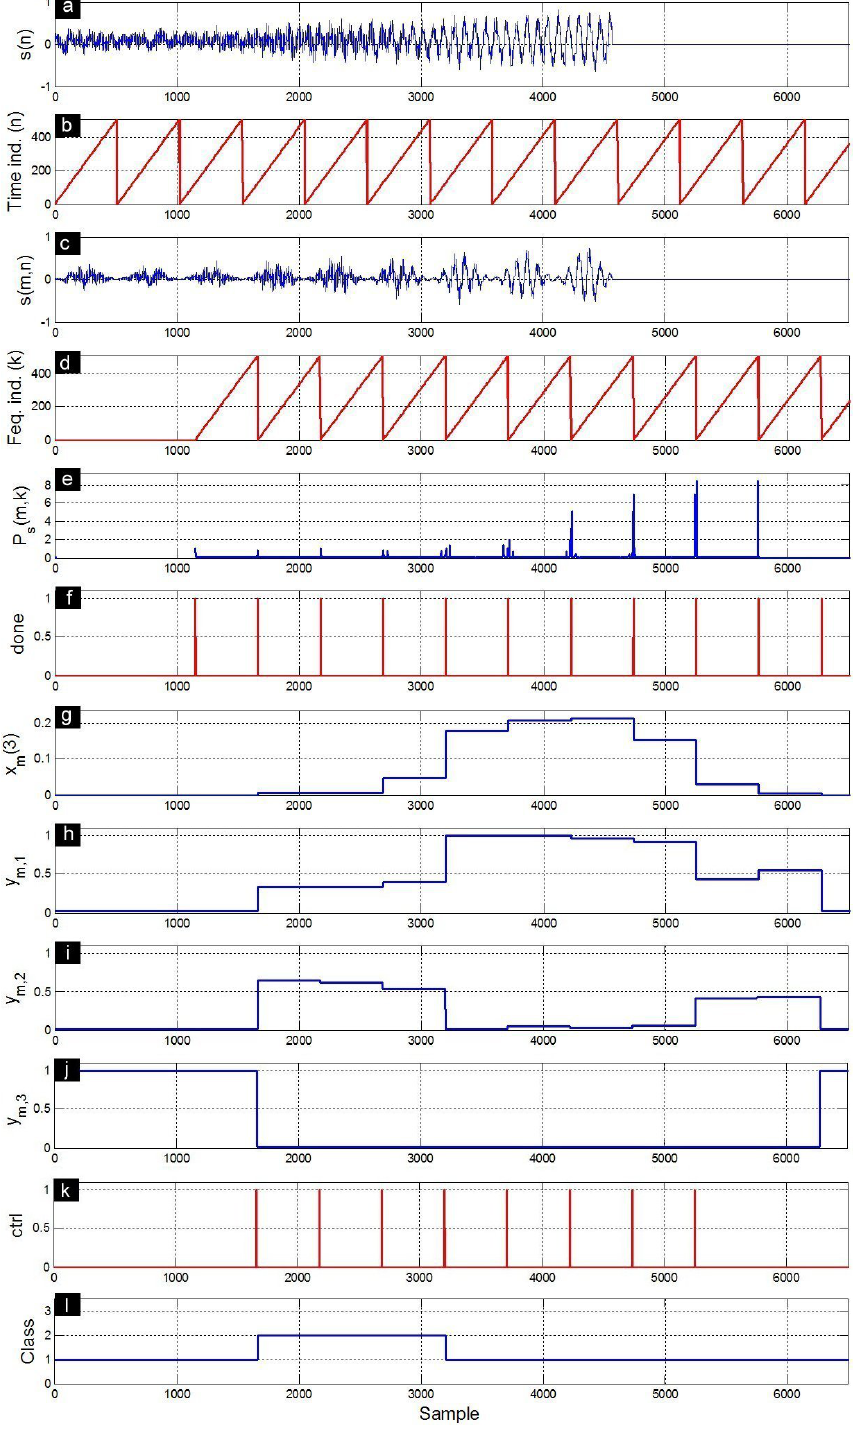
Figure 9. Response signals obtained during the characterization/classification of an A call. ( a ) input signal s ( n ) ; ( b ) time index n that allows to delimit successive frames s ( m , n ) ; ( c ) windowed signal s ( m , n ) ; ( d ) frequency index k that allows to delimit successive power spectra; ( e ) power spectra P s ( m , k ) ; ( f ) done signal; ( g ) third component of the feature vector x m ( 3 ) ; ( h ) first MLP output y m ,1 ; ( i ) second MLP output y m ,2 ; ( j ) third MLP output y m ,3 ; ( k ) ctrl signal; and ( l ) recognized